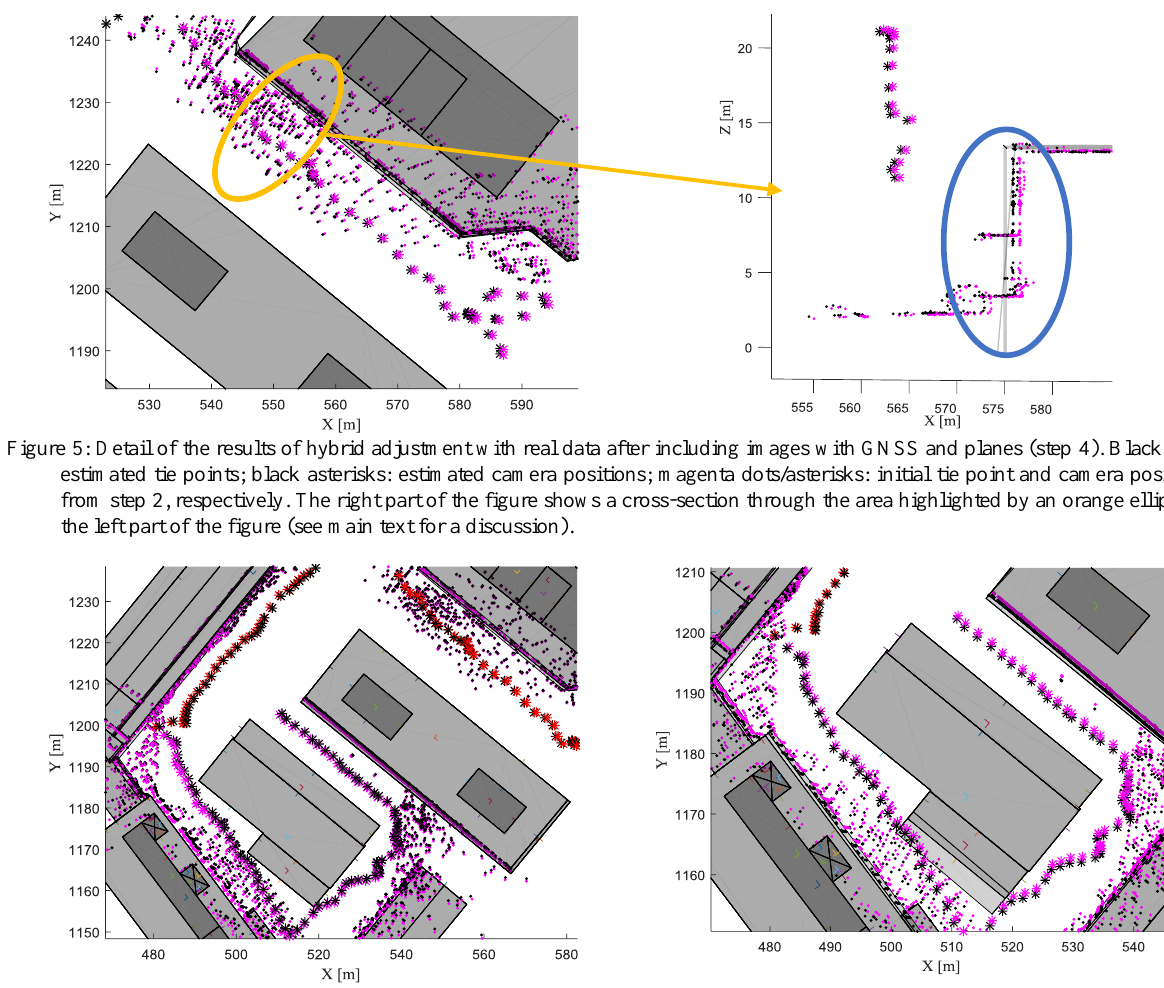
Figure 6: Results of two variants of hybrid adjustment. Black dots: estimated tie points; black asterisks: estimated camera positions; magenta dots/asterisks: initial positions of tie points/camera positions, i.e., results of the previous processing steps. Red asterisks: GNSS observations of camera positions. Left: Results of the hybrid adjustment with real data after step 5 including new images but no new planes. Right: Results after step 6, including all planes..